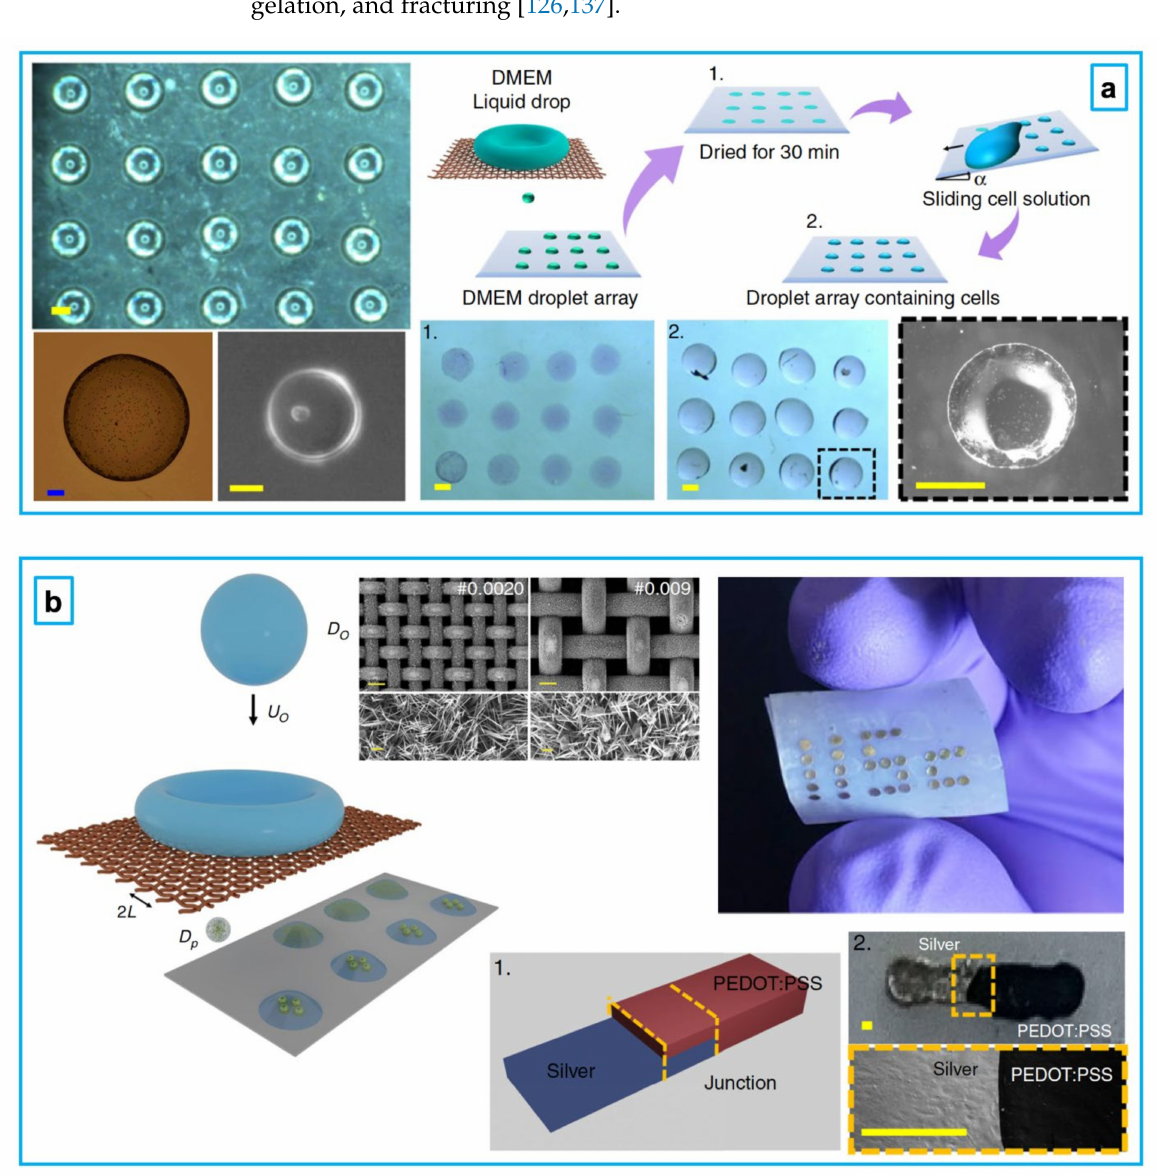
Figure 4. ( a ) Droplet-based bioprinting of droplets containing biological solutions to produce bioma- terials [132]. ( b ) Droplet-based printing of electrically conducting droplets containing silver inks on soft materials to produce soft elastic printed electronics